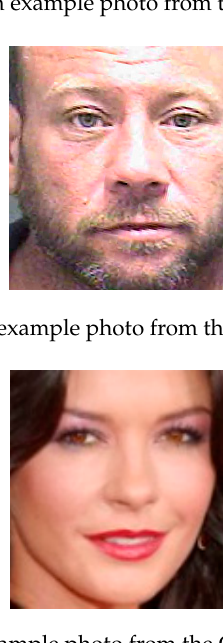
Figure 12. An example photo from the Morph database. Figure 13. An example photo from the CACD2000 database. Figure 13. An example photo from the CACD2000 database. Table 16. Recognition results of the CIA photo. Table 17. Recognition results of the Morph photo. Table 18. Recognition results of the CACD2000 photo.